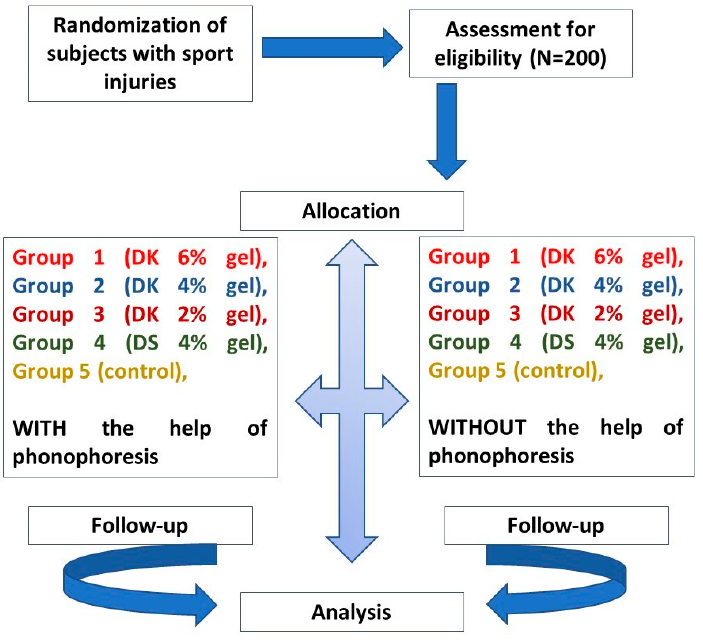
Figure 8. Consolidated Standards of Reporting Trials (CONSORT). DK stands for Diclofenac potas- sium, and DS means Diclofenac sodium (used as a standard). Control group is the placebo.